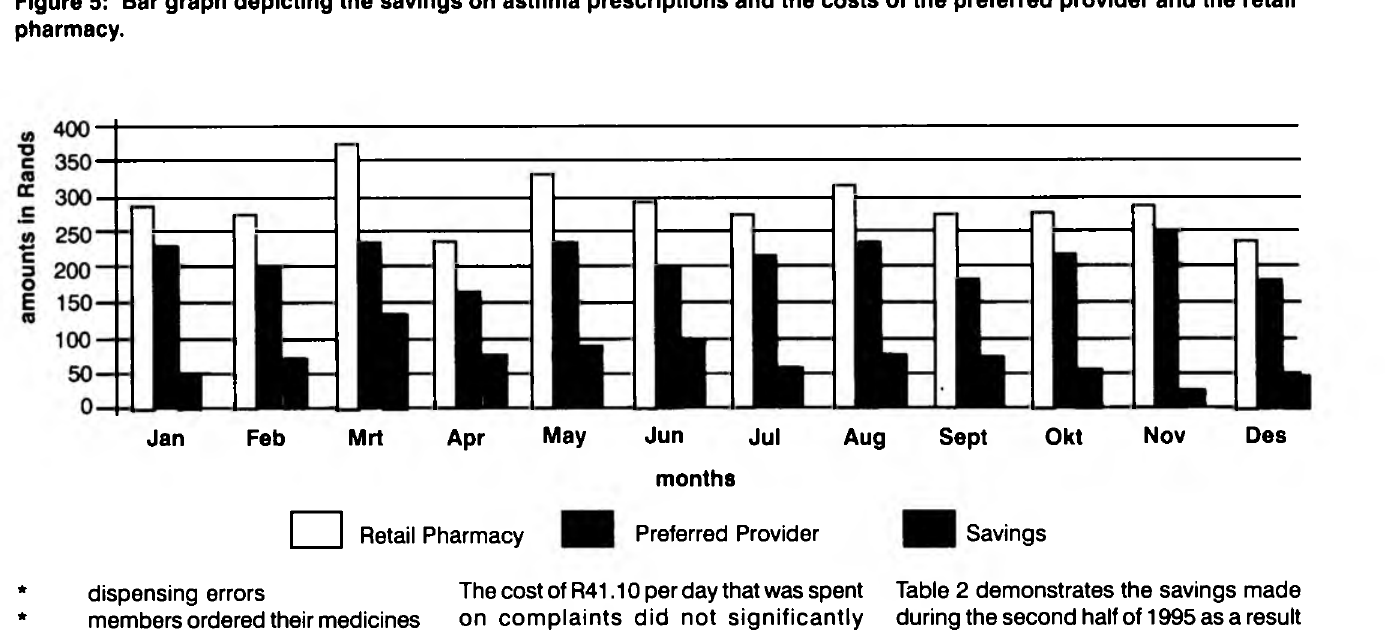
Table 2 demonstrates the savings made during the second half of 1995 as a result of managed care